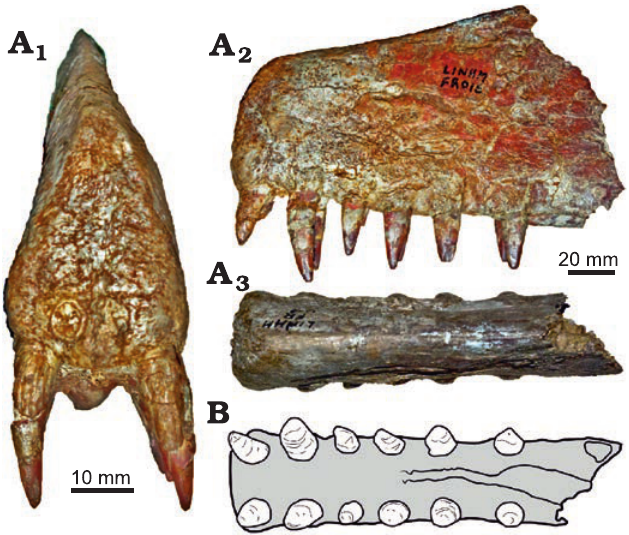
Fig. 8. Tropeognathine pterosaur Siroccopteryx moroccensis Mader and Kellner, 1999, LINHM FR016, Kem Kem beds, Morocco, ?Albian–lower Cenomanian. A . Photograph in anterior (A 1 ), left lateral (A 2 ), and dor­ sal (A 3 ) views. B . Interpretation of the palatal view following Mader and Kellner (1999). Photographs courtesy of Megan L. Jacobs. Drawing by RVP based on Mader and Kellner (1999).